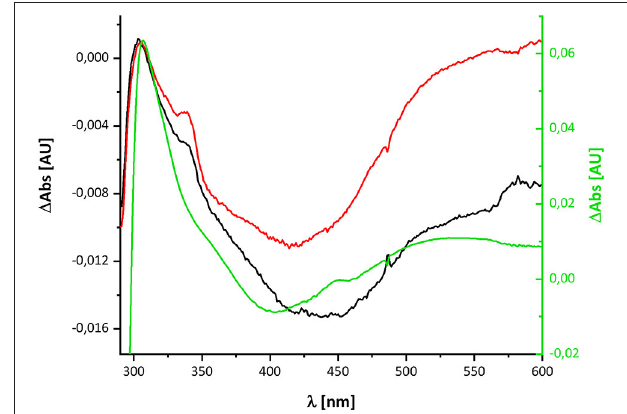
FIGURE 4 | Comparison of the redox-difference spectra of the component detectable after NADH re-oxidation in wild type in black and D213G H variant in red and that of the quinol anion in green.